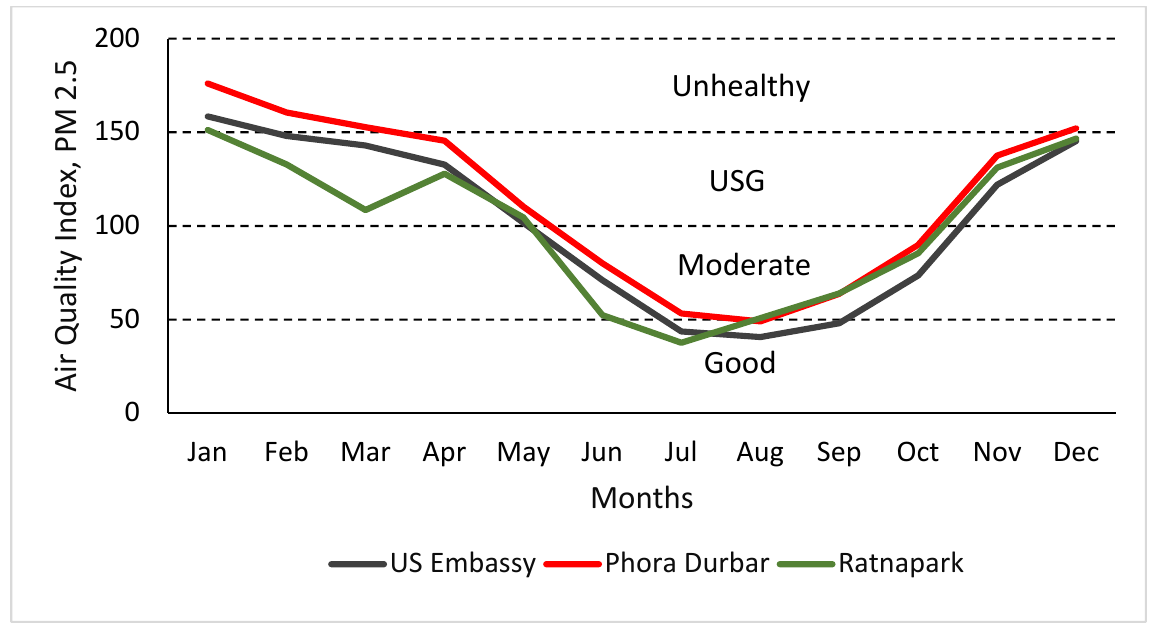
Figure 4. Land Surface Temperature Maps of KMC for the years of 2017, 2018, and 2021.